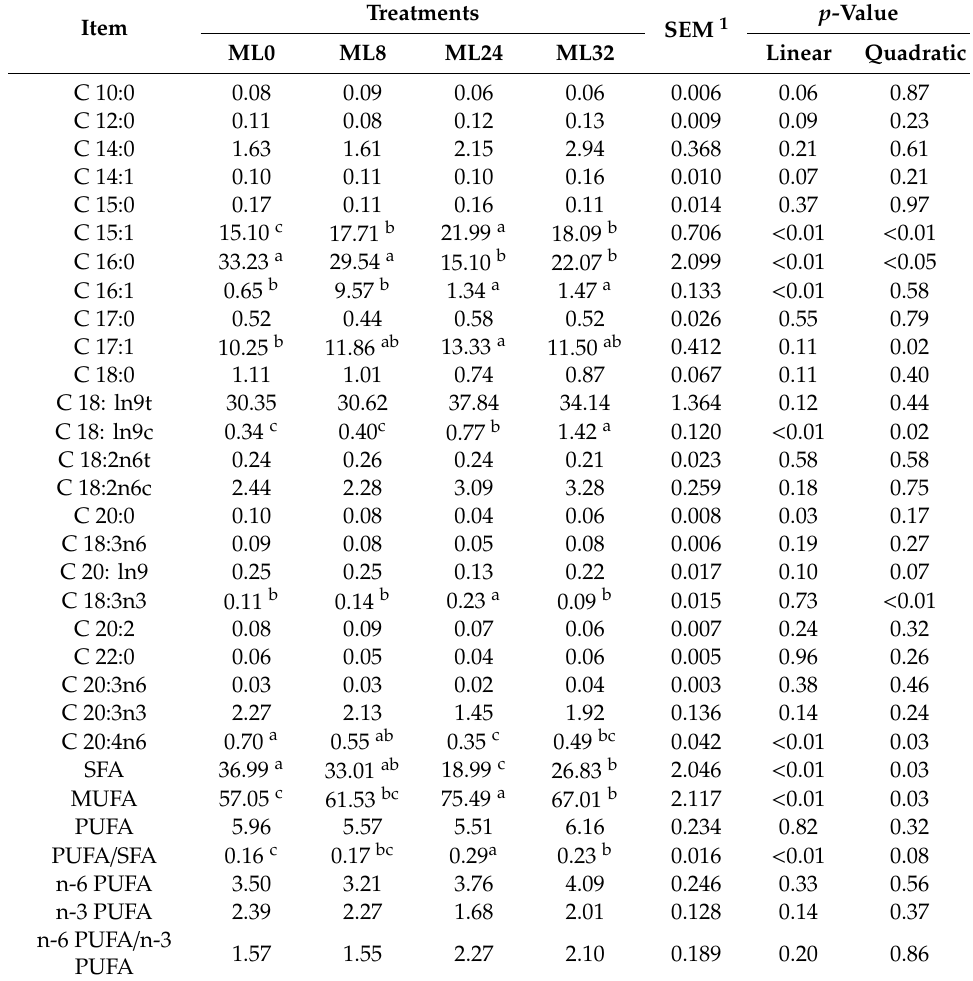
Muscle fatty acid composition data are summarized in Table 8. The proportion of C15:1, C18:In9c, C18:3n3, MUFA, and the PUFA: SFA ratio in LM were higher in the ML24 treatment than in the ML0 treatment, and the proportion of C16:0 and SFA were lower in the ML24 treatment than in other treatments. Table 8. E ff ects of inclusive ML treatments on fatty acid composition in longissimus dorsi muscle of sheep